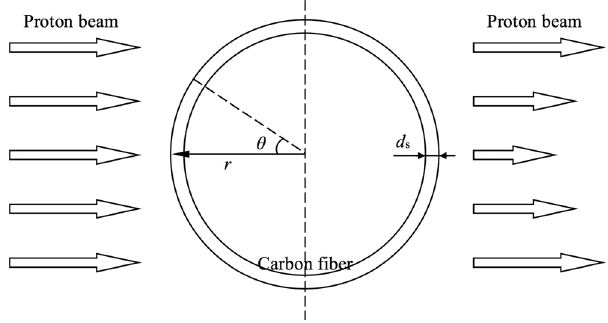
FIG. 2. Cylindrical model of the secondary electron